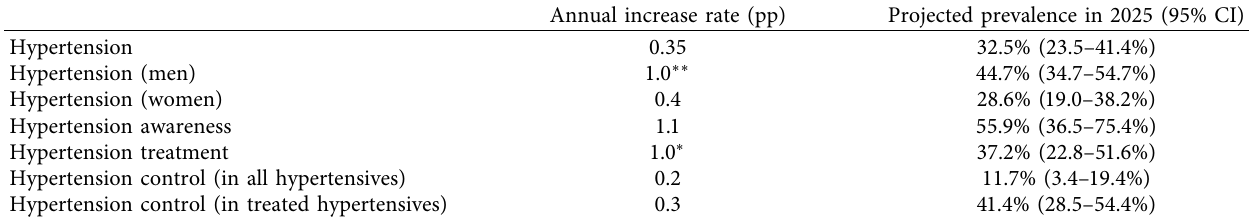
Table 3: Projected prevalence of hypertension, awareness, treatment, and control for 2025.